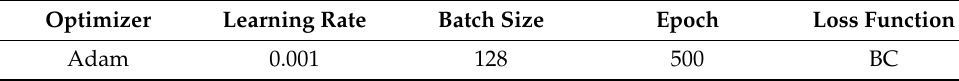
Table 3. The utilized hyperparameters.